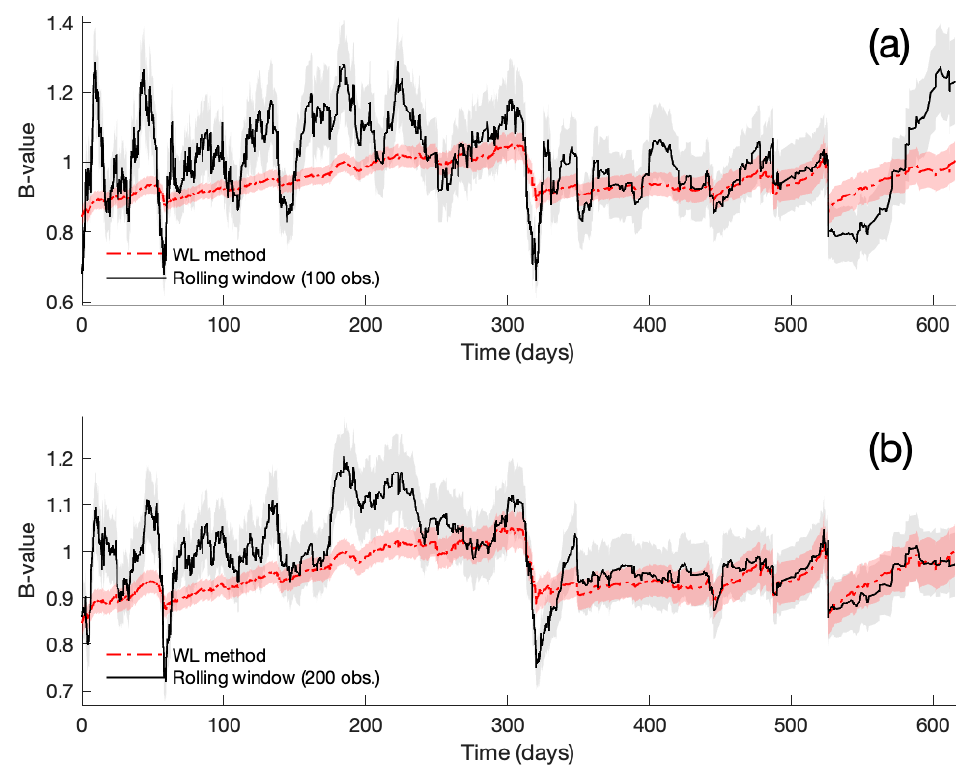
Figure 4. Comparison of the estimated b-value (with uncertainties, +/ − sigma, shaded areas) for the WL method (red) and rolling window (black) applied to the TABOO testing dataset; panel ( a ) represents the rolling window method using 100 observations, and in panel ( b ) using 200 observations.